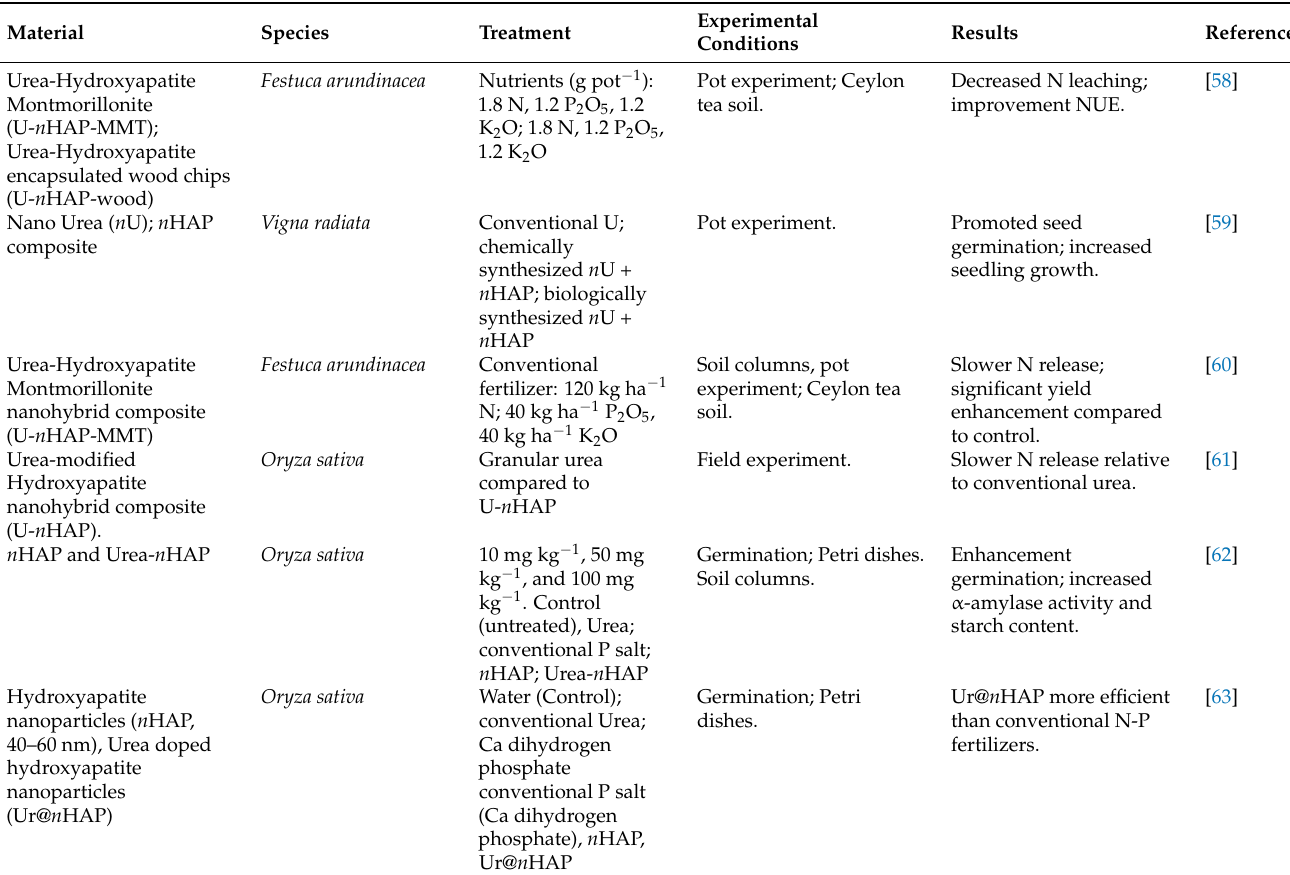
Table 2. Nano-hydroxyapatite as N-carrier.